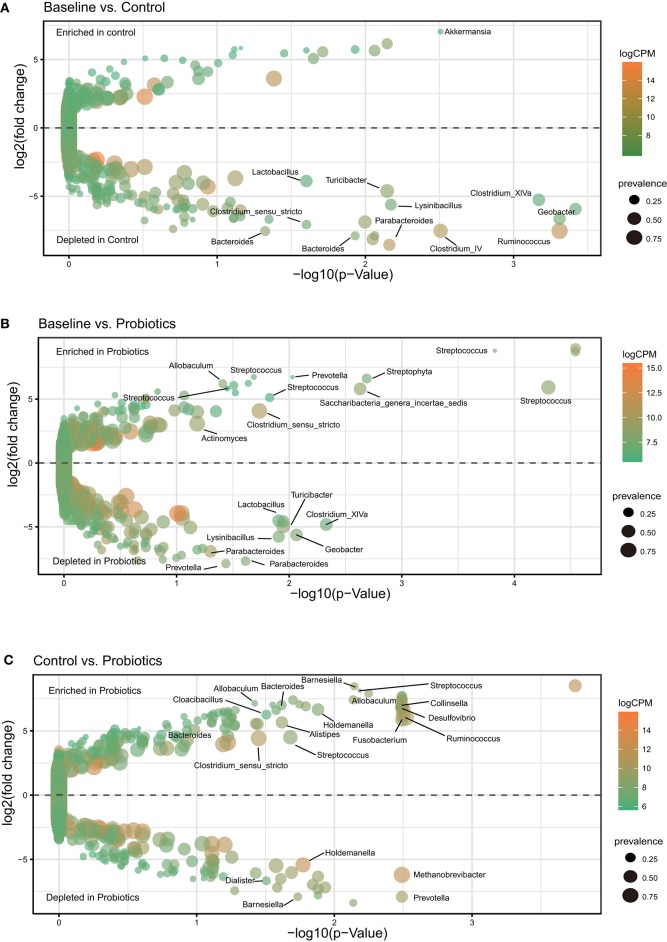
OTUs differentially abundant during pregnancy. Only the OTUs that were assigned to the Greengenes 16S rRNA gene reference database at the genus level and had significant differences were labeled. (A–C) Volcano plot of the OTU abundance demonstrates intragroup differences. The y-axis represents the log2-fold change of relative abundance calculated by EdgeR, and the x-axis is the p-value adjusted by the Benjamini-Hochberg method. CPM, counts per million; prevalence indicates the percentage of participants in which a given OTU is present.